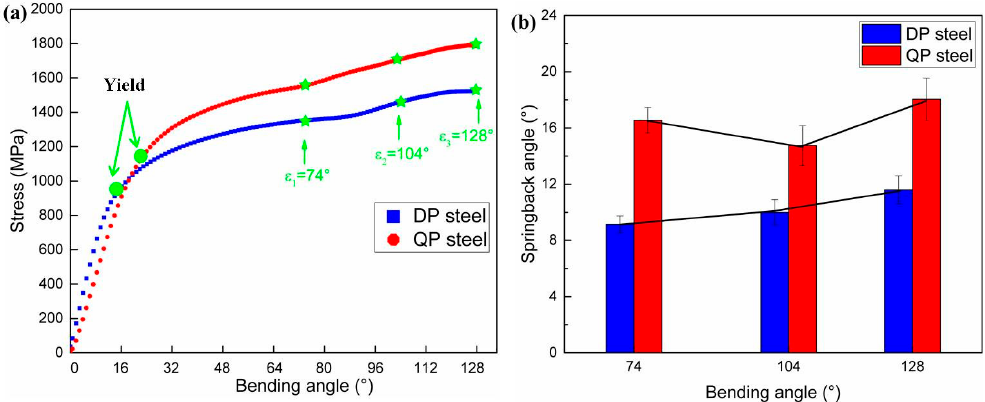
Figure 3. Bending springback properties of the DP and QP steel. ( a ) Stress-bending angle curves; ( b ) Springback angle of DP and QP steel strained at different bending angles.